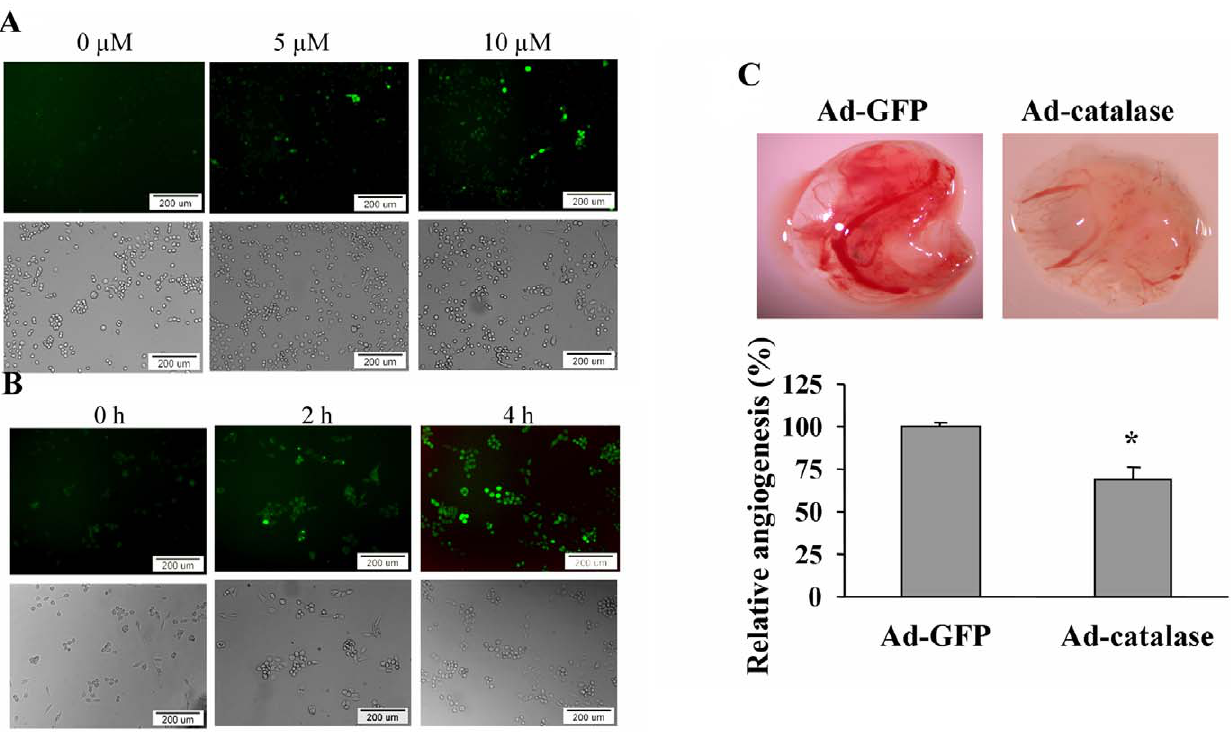
Figure 4. Arsenic induced ROS production in BEAS-2B cells, which was required for angiogenesis . (A) BEAS-2B cells were seeded into 6- well plates. Cells were treated with different doses of arsenic as indicated in serum-free medium. DCFH-DA at 5 m M was added to the cells for 15 min. Then the cells were washed and fixed, and the fluorescent images were captured using a fluorescent microscope (upper panel). The corresponding phase micrographs were shown in the bottom panel. (B) BEAS-2B cells were seeded into the 6-well plate. The cells were then cultured in serum-free medium with arsenic at 5 m M for different time points as indicated. DCFH-DA staining was performed as above. (C) BEAS-2B cells were infected with adenovirus carrying GFP (Ad-GFP) and catalase (Ad-catalase), respectively at 20 MOI. After 24 h, cells were treated with 5 m M arsenic for 5 h to perform angiogenesis assay. *, indicates that the relative angiogenesis index was significantly decreased when compared with Ad-GFP control group, P , 0.05.